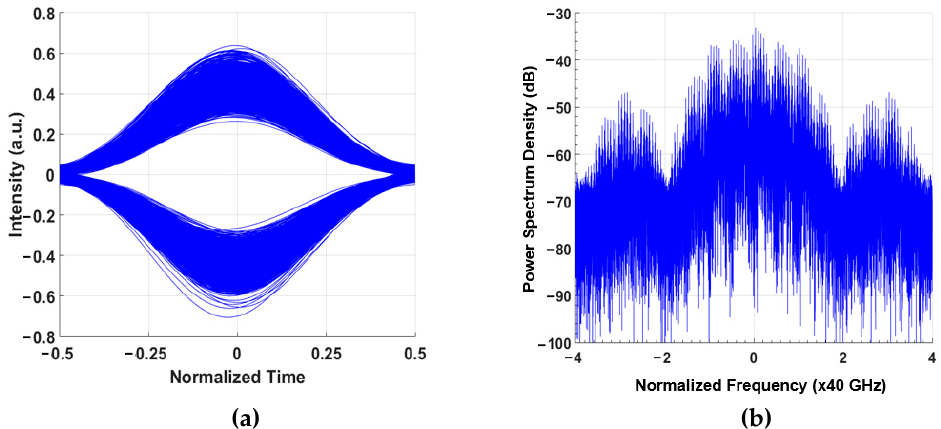
Figure 8. Eye diagram ( a ) and power spectrum density (PSD) ( b ) of the in-phase signal (real part) of an 80 Gb/s DQPSK signal using the three-segment hybrid fiber effective core area structure after transmission over 390 km.